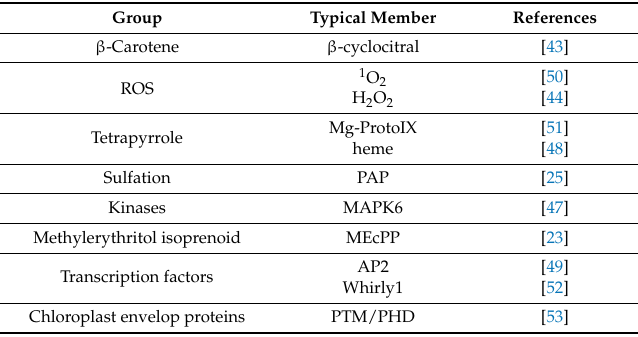
Table 1. Source of typical retrograde signals in